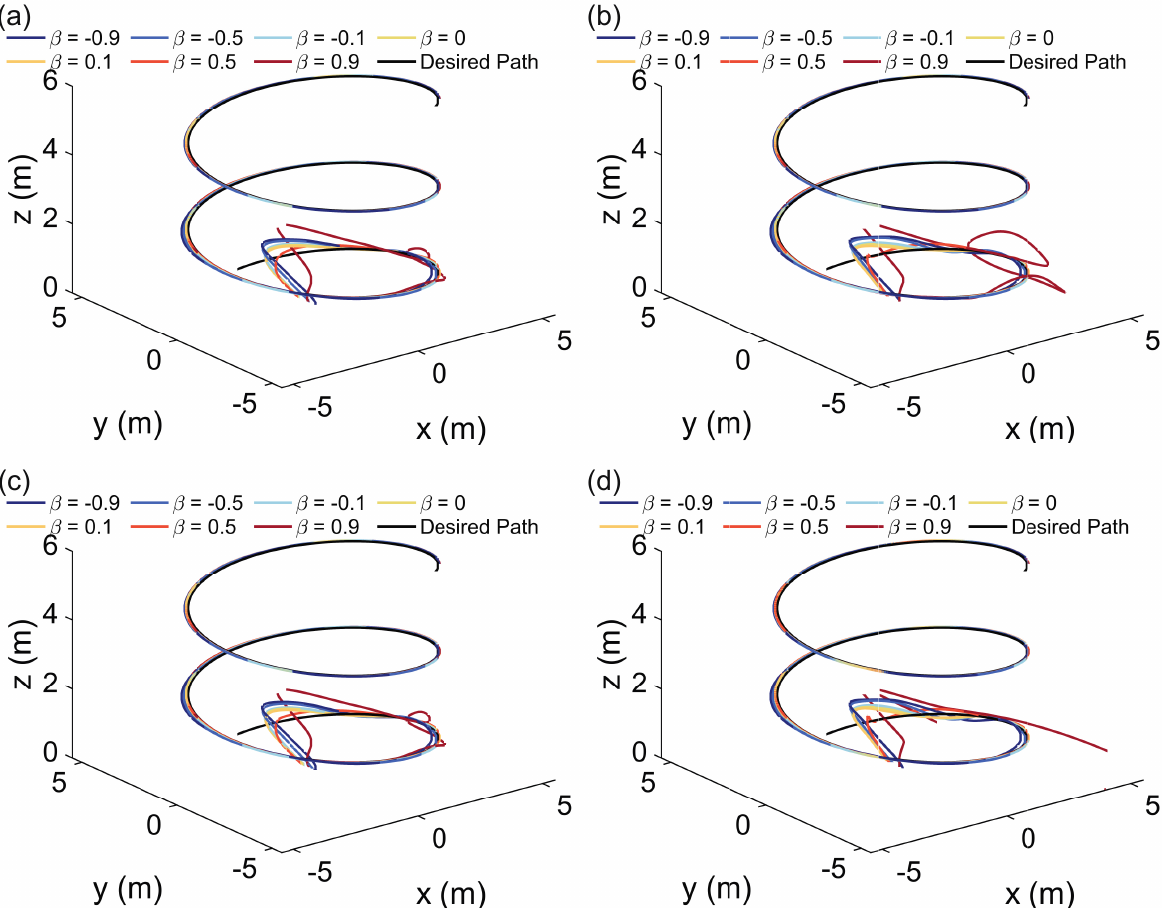
Figure 7. Simulated results that demonstrate the robustness of the varying fractional orders in the proposed controller to uncertainty in the quadrotor dynamics with various payloads and uncertain input time delays: ( a ) 𝑑 (cid:2871) = 2 m/s 2 and 𝜏 = 0.05 s, ( b ) 𝑑 (cid:2871) = 2 m/s 2 and 𝜏 = 0.10 s, ( c ) 𝑑 (cid:2871) = 4